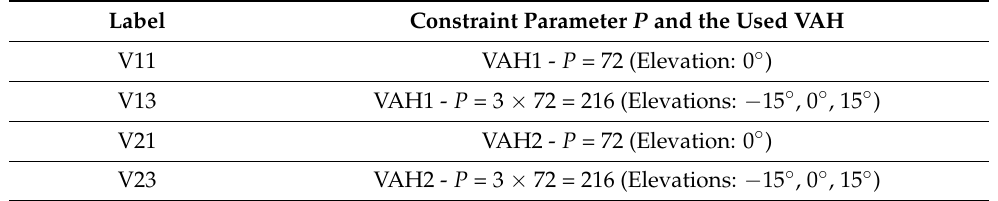
Table 1. An overview of parameter P and the VAHs used to calculate the spectral weights. Label Constraint Parameter P and the Used